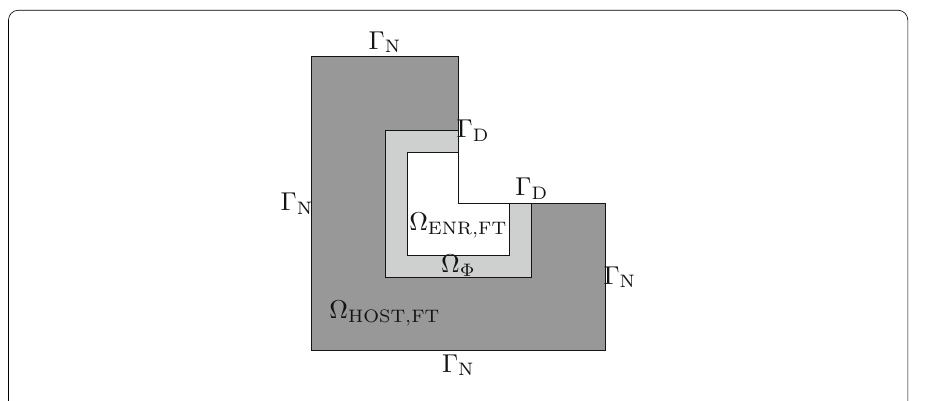
Fig. 4 Sketch of a non-convex domain (cid:5) in two dimensions depicting the employed partitioning into (cid:5) (cid:6) = (cid:5) ∩ (cid:5) (cid:5) (cid:5) (cid:14) HOST , FT (drak gray), HOST ENR (light gray), and ENR , FT (white). The boundary data for this model · n on (cid:7) problem is given by g = 0 on (cid:7) D and h = ∇ N where n denotes the outer normal